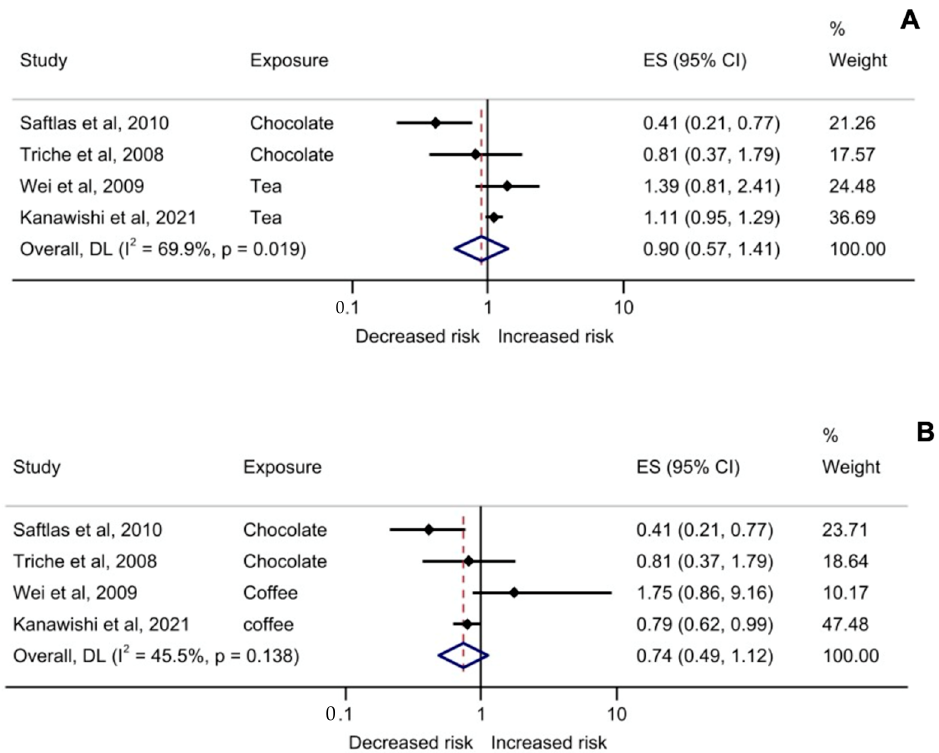
Figure 3. Forest plots for the pooled adjusted effect size of polyphenol-rich foods consumption and risk for preeclampsia in pregnant woman. Including Triche et al., 2008 [20], Saftlas et al., 2010 [22], and in ( A ) tea as polyphenol-rich food estimator for preeclampsia risk for Wei et al. (2009) [21] and Kanawishi et al. (2021) [23] was included; and in ( B ) coffee as polyphenol-rich food estimator for preeclampsia risk for Wei et al. (2009) [21] and Kanawishi et al. (2021) [23] was considered. Abbreviations: CI = confidence interval; ES = effect